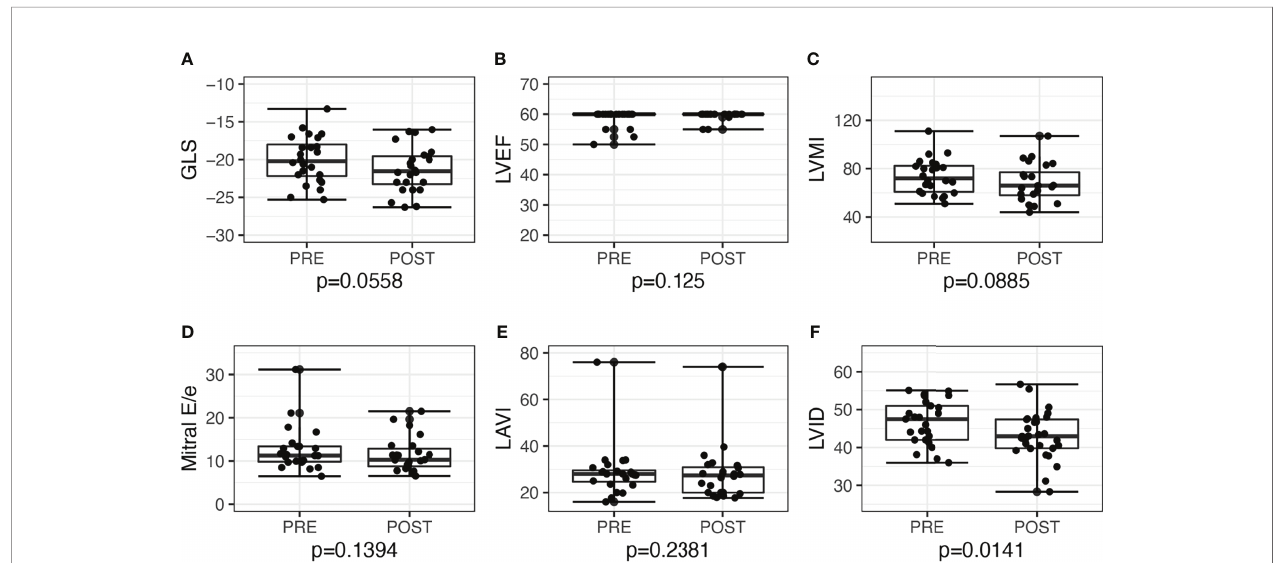
FIGURE 3 | Echocardiographic parameters before and after medical treatment among patients with primary aldosteronism (n = 24). (A) Global longitudinal strain (GLS) but not in (B) left ventricular ejection fraction (LVEF). (C) Left ventricular mass index (LVMI); (D) mitral E/e ’ ; (E) left atrial volume index (LAVI); (F) Left ventricular internal dimension